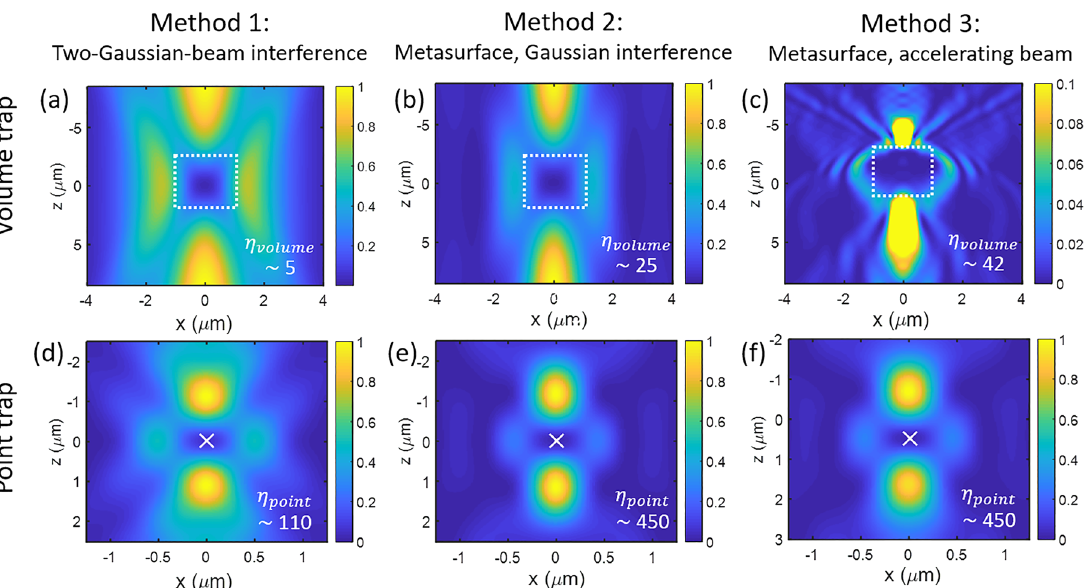
Figure 3: Results of the parameter-sweep optimization for generating optical bottle-beam traps at λ 0 = 770 nm based on three different methods: Using the destructive interference of two Gaussian beams (Method 1), illuminating a single Gaussian beam on an optical meta- surface whose phase pro fi le is used to mimic the two-Gaussian-interference beam (Method 2), and reverse phase retrieval from an accel- erating beam (Method 3).